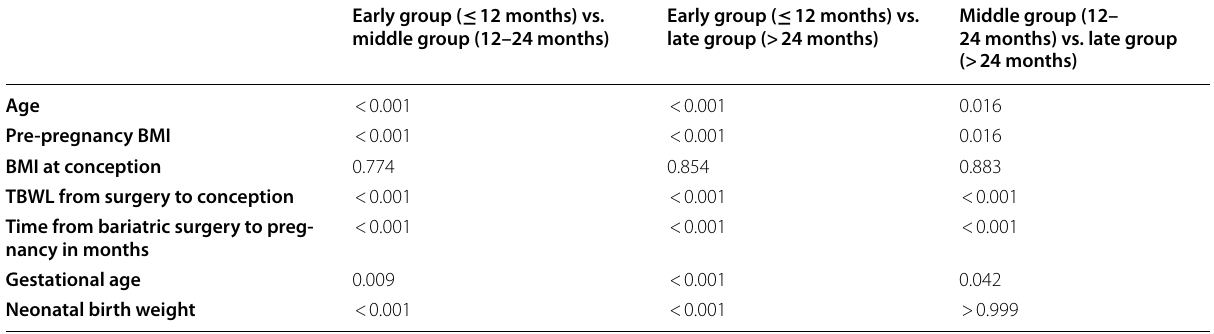
Table 4 Post‑hoc test using Dunn’s multiple comparison, to indicate which groups were significantly different from each other